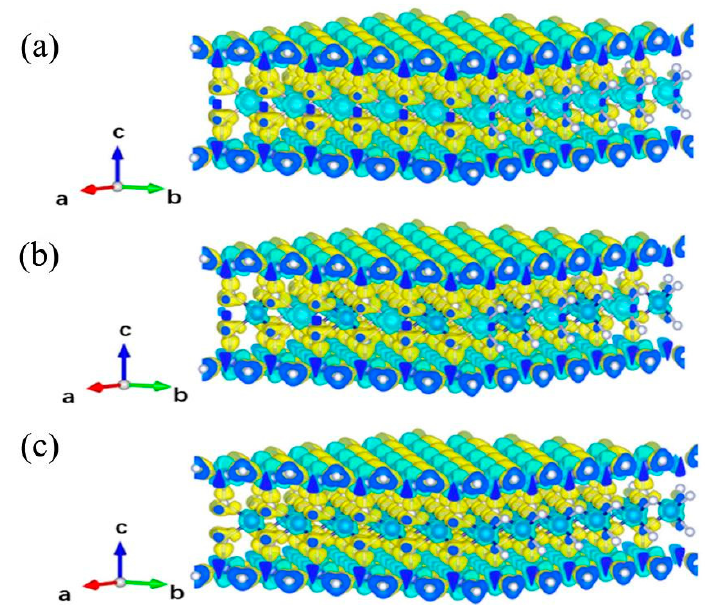
Figure 3. 3D charge density difference in ( a ) MoSi 2 N 4 , ( b ) Mo 0.5 Cr 0.5 Si 2 N 4 , and ( c ) CrSi 2 N 4 with an isosurface of 0.015 e/e/Å3. Yellow and blue isosurfaces represent charge accumulation and depletion, respectively.